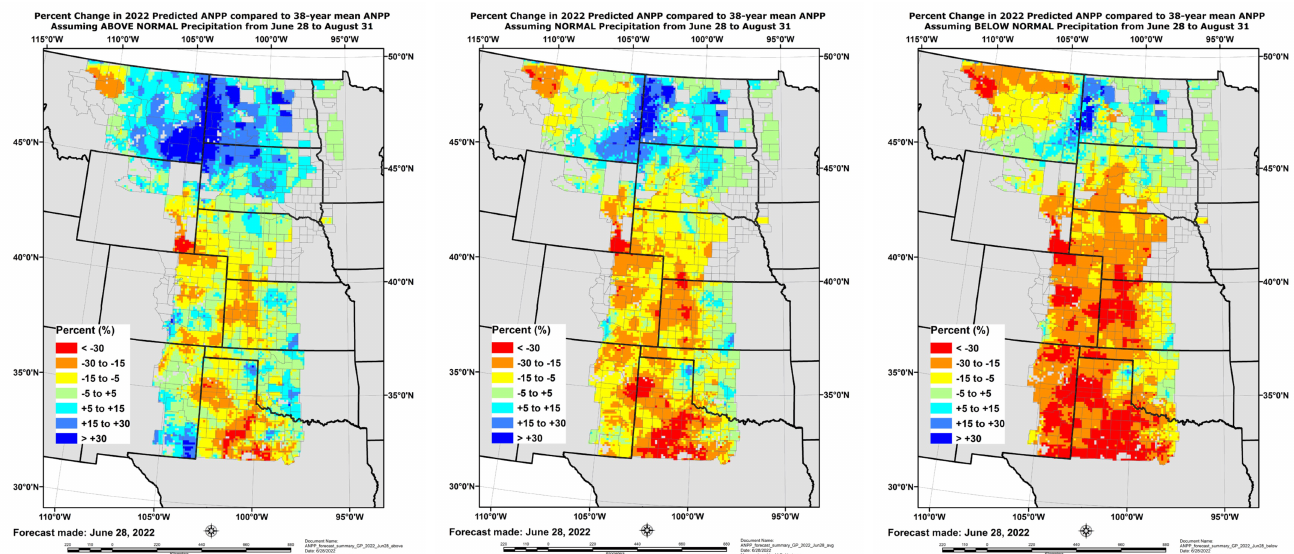
Figure 8. Grass-Cast maps of above-ground net primary productivity (ANPP) with scenarios for precipitation above normal ( left map ), near normal ( middle map ), and below normal ( right map ). Map archive data of Great Plains for date 28 June